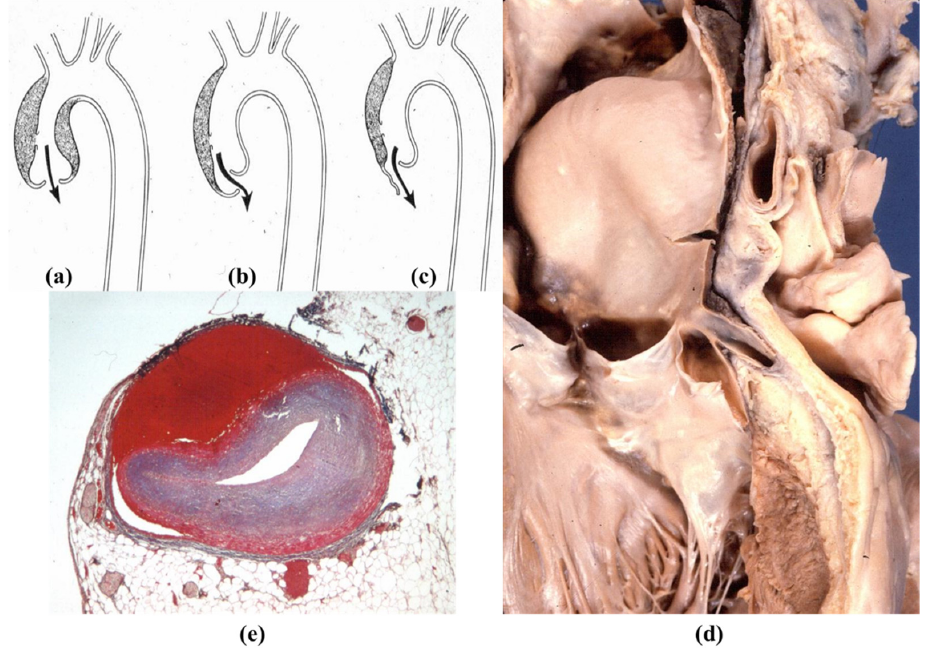
Figure 22. ( a – c ) Drawing of aortic incompetence due to retrograde aortic dissection. ( d , e ) Retrograde dissection involves and occludes the left coronary artery main stem (Azan Mallory stain).